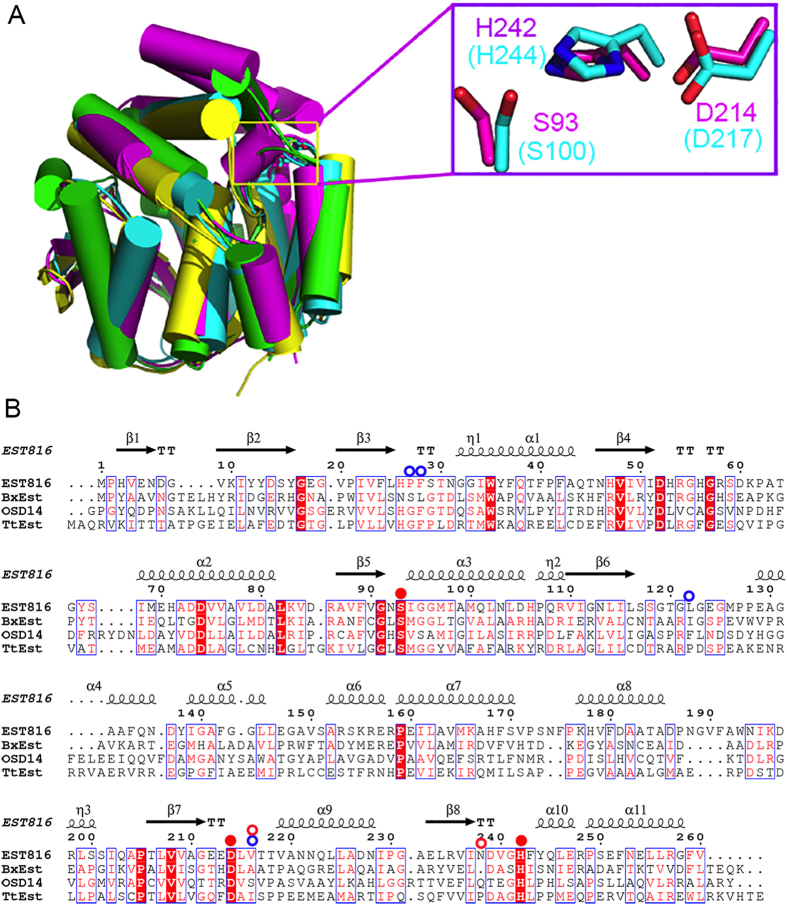
The structure and sequence comparison with orthologs from other organisms.(A) Structure overlay of the polypeptide backbones (represented as Cα traces) of Est816-M2 (magenta, PDB 5EGN), BxEst (cyan, PDB 2XUA), TtEst (yellow, PDB 4UHH), as well as OSD14 (green, PDB 3VXK). The catalytic triad in the close-up view is shown in the top-right corner. (B) Multiple sequence alignment of Est816 primary sequences as in (A). The secondary structure of M2 is drawn on the top. Identical residues in sequences are in magenta and yellow, and similar residues in cyan. The residues of the catalytic triad are shown by the red solid dots, while the positions screened from two rounds of mutagenesis studies were shown by red and blue open dots respectively.